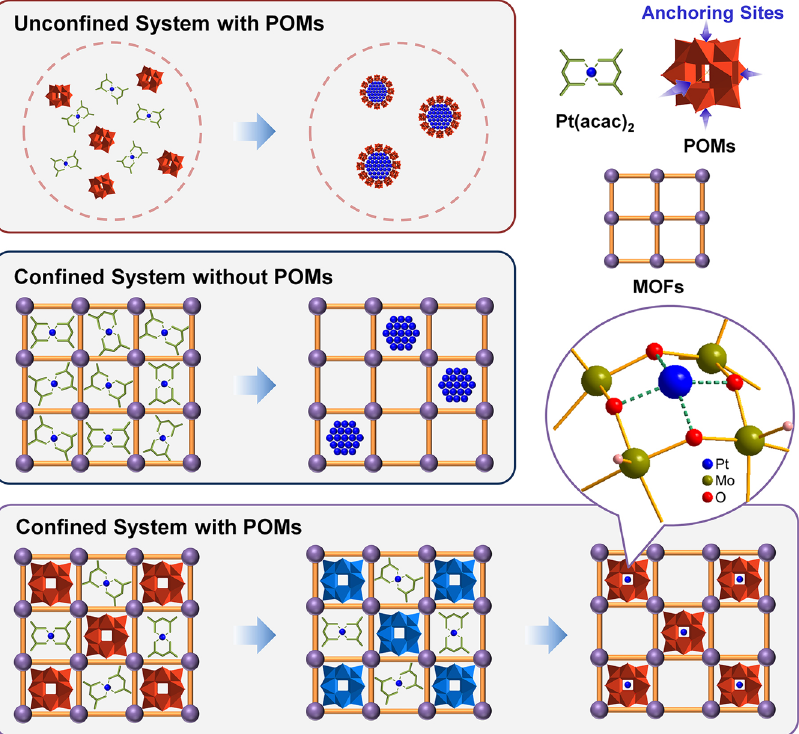
Fig. 1 Schematic illustration of the fabrication of different Pt nanomaterials. Pt nanoparticles are formed in the absence of either POMs or MOFs, and POM-stabilized single Pt atom sites can be constructed in the restricted domain space of MOFs.